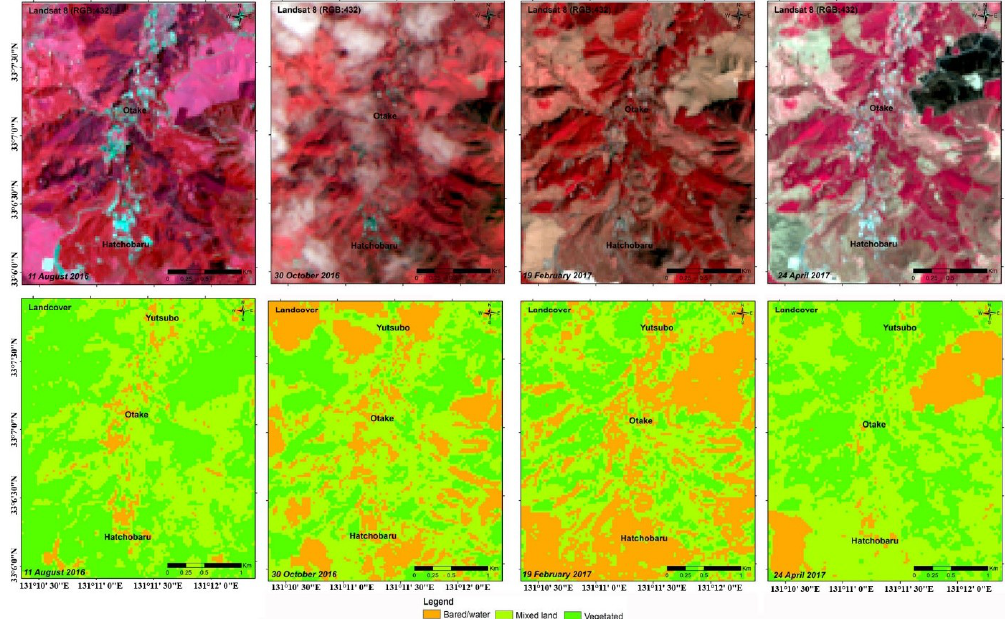
Figure 11. False colour composites of near infrared/red/green bands of the Landsat 8 OLI images as red/green/blue (RGB) of the study area for each season (top row). The bottom row shows the land cover types in each season.